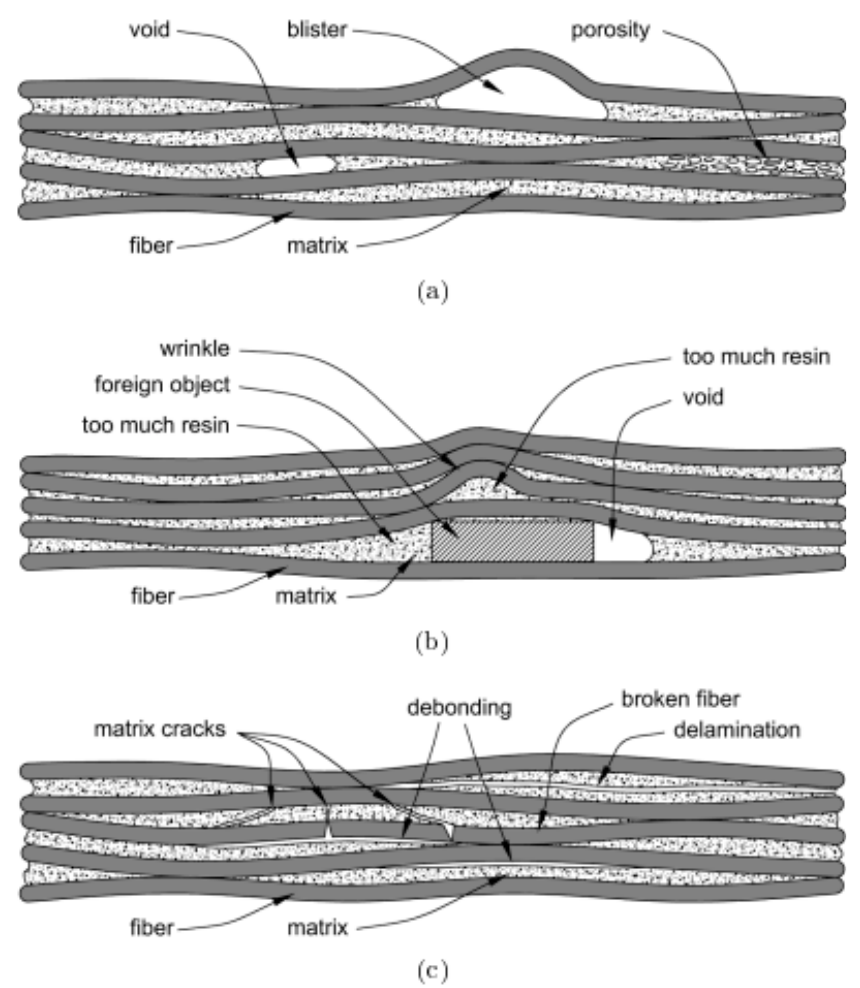
Figure 29. Typical damage in PMCs induced during the manufacturing process due to ( a ) improper curing processing, ( b ) incorrect fiber volume distribution and foreign bodies, and ( c ) insufficient wetting of fibers and lack of adhering between fibers and polymer matrix [98].